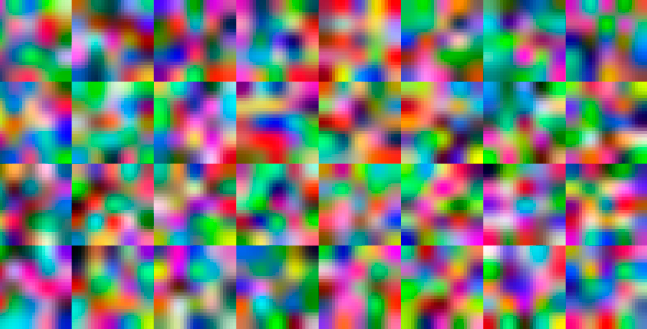
Figure 9. An example of ConvMixer first convolution layer weights after a training was carried out.